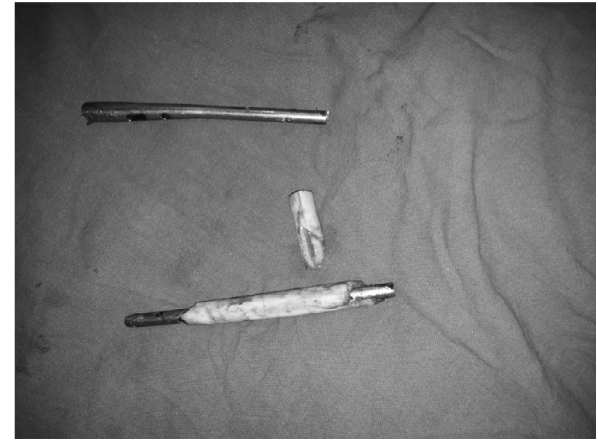
Figure 2. Sequestrum over a Table 3. Complications.